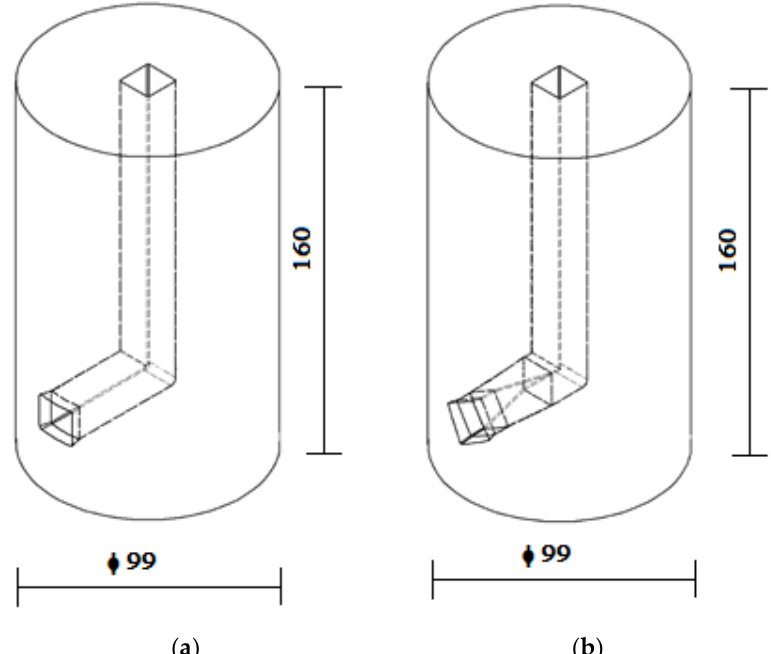
Figure 1. Schematic illustration of the equal channel angular pressing (ECAP) die channel: conventional ECAP geometry ( a ); ECAP geometry with the helical horizontal channel, i.e., twist channel angular pressing (TCAP) ( b ).